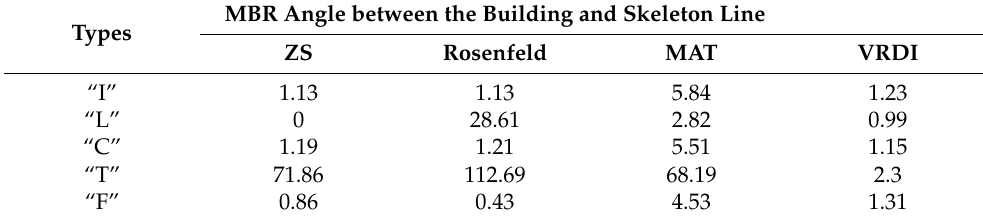
Table 2. MBR angle between the building and skeleton line in Figures 18 and 19.